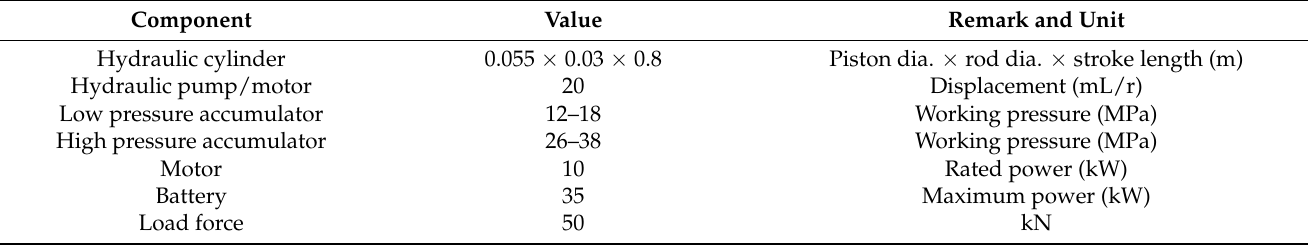
Table 1. Hydraulic components and